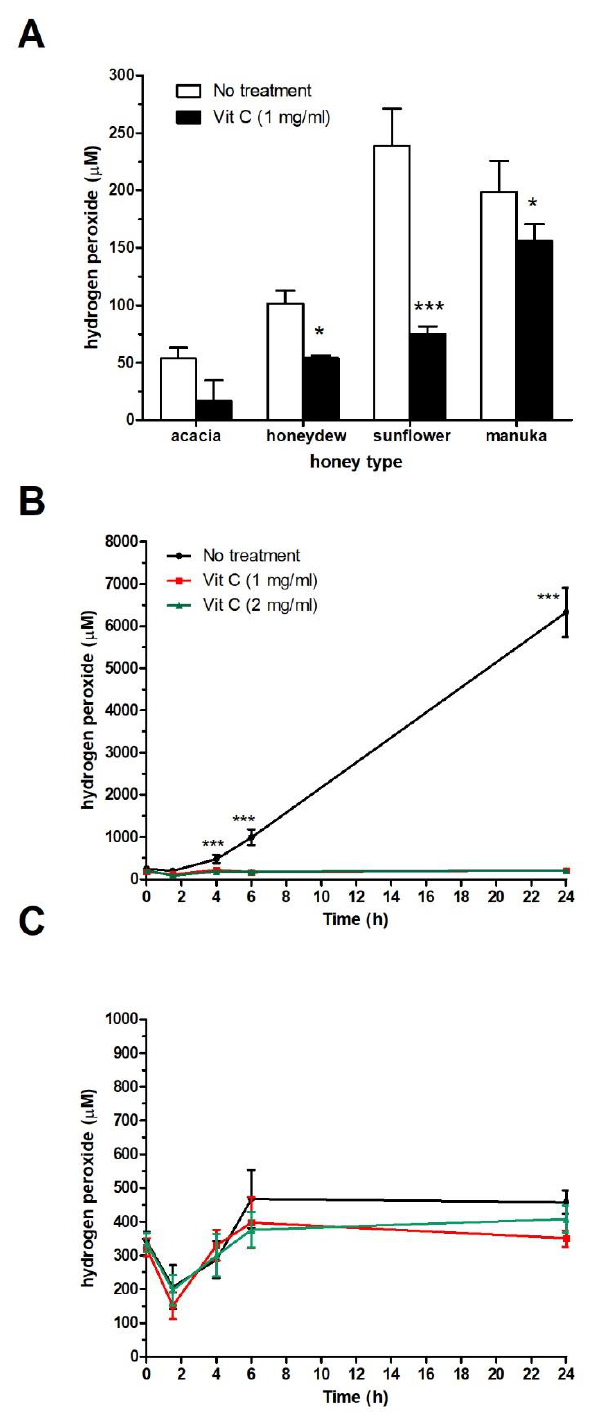
Figure 4. Neutralization of hydrogen peroxide (H 2 O 2 ) in different honey solutions after supplementation with vitamin C (Vit C) at sub-inhibitory concentration. ( A ) H 2 O 2 content was measured in non-incubated, 40% ( w / v ) acacia, honeydew, sunflower, and manuka honey solutions supplemented with Vit C with a modified glucose oxidase (GOX) assay kit. ( B ) H 2 O 2 production was measured in 40% ( w / v ) honeydew and ( C ) manuka honey solutions with a modified GOX assay kit after 2, 4, 6, and 24 h of incubation at 37 °C. The data are expressed as mean values with standard deviations. ** P 0.01, and *** P 0.001.